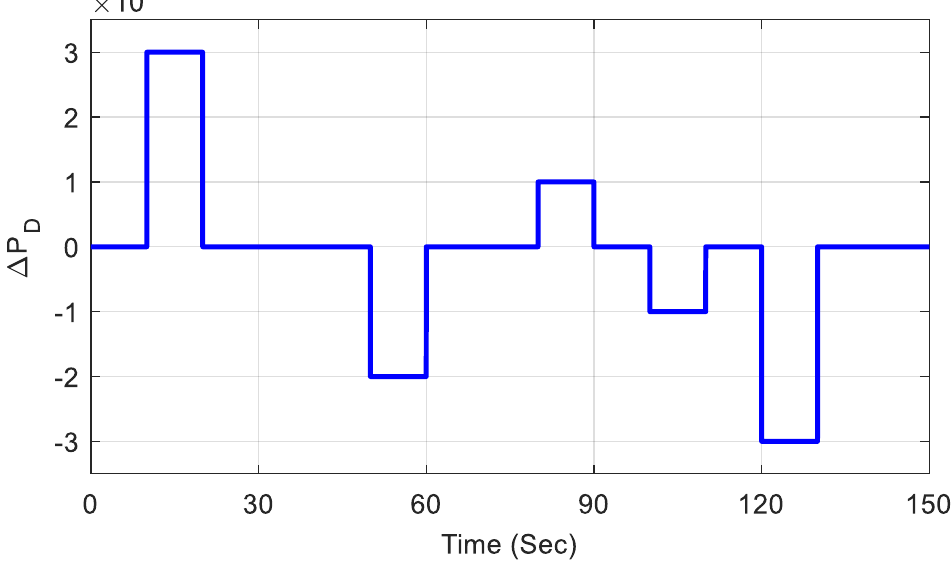
Figure 10. Random step load variation.